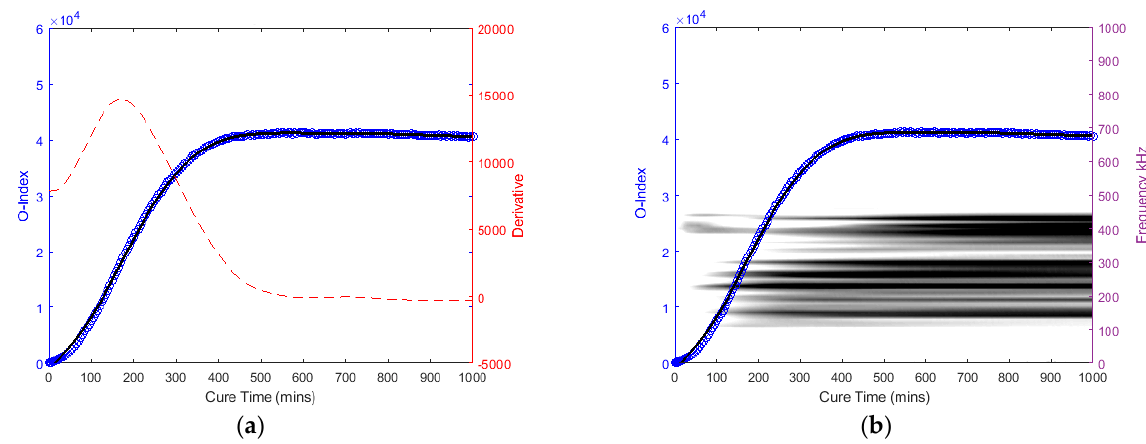
Figure 17. Triangular specimen (Far): O-Index with ( a ) its time derivative and ( b ) its change in frequenc y.